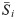
Schematic representation of the protein complex.Solid lines border both proteins, while the surface regions are coloured grey. Interacting amino acids are connected with lines, forming a network. Sa denotes the set of surface residues of the protein that a is a residue of, S¯i denotes the set of surface residues of the protein that i is not a residue of, and I denotes the set of interactions across the interface.